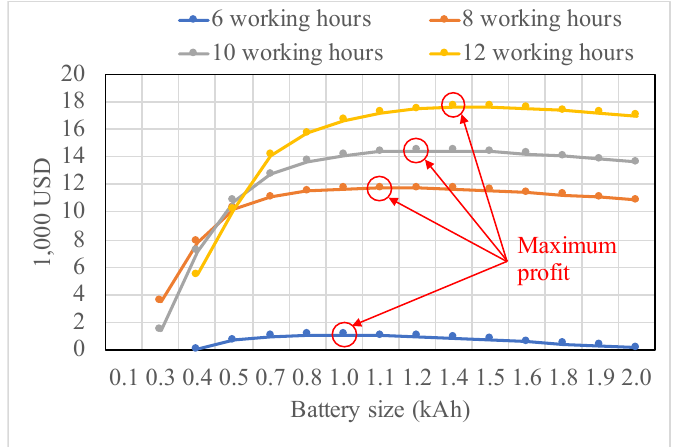
Figure 7. Annual profit by working